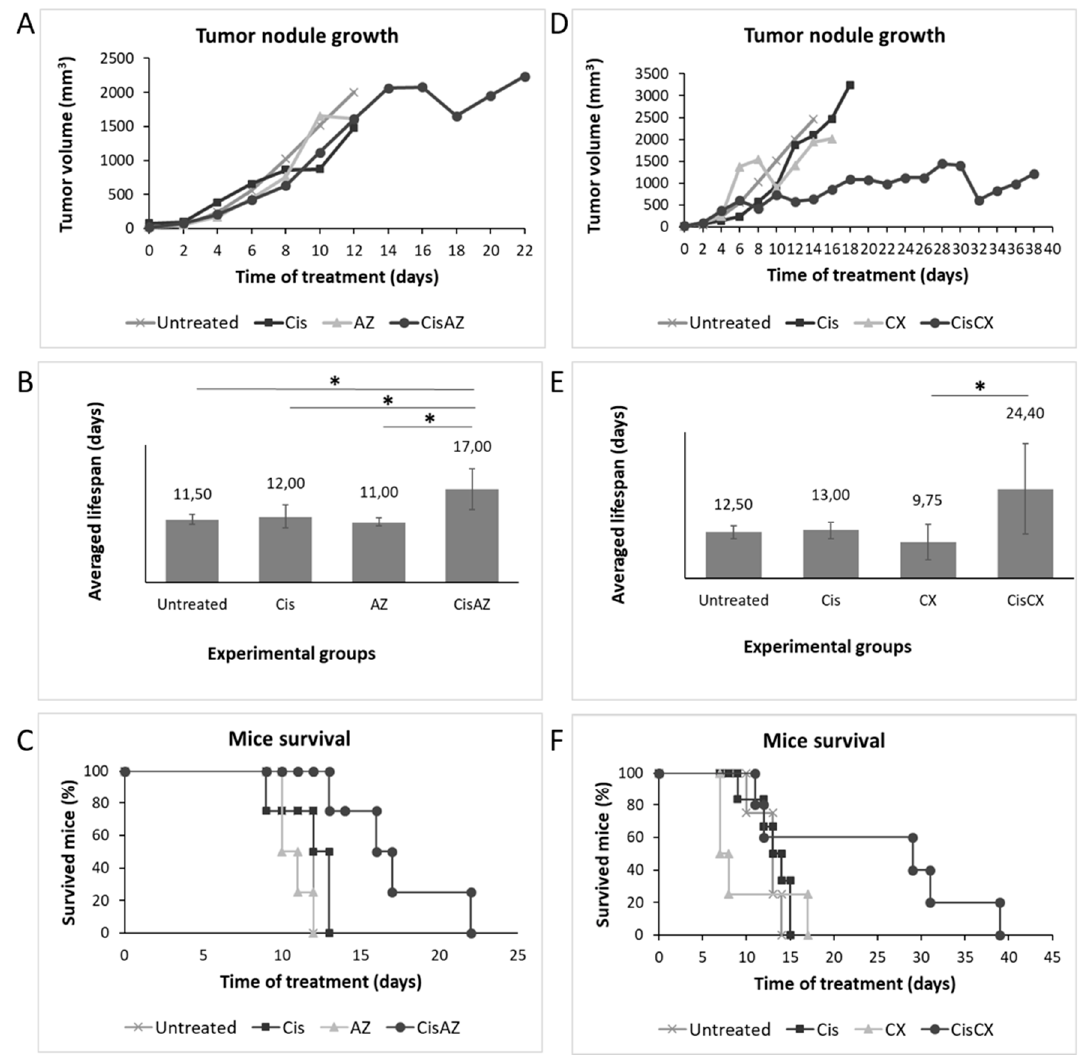
Figure 6. Pharmacological inhibition of MCM2 and CA9 in vivo. The effects of MCM2 and CA9 pharmacological inhibition on tumor nodule growth ( A , D ), averaged lifespan ( B , E ) and Kaplan Meier survival analysis ( C , F ) during the treatments with Acetazolamide and Ciprofloxacin are reposted as the average of each group of treatment. Significance in lifespans was calculated by Log rank test. Statistical significance is displayed as p < 0.05 (*).